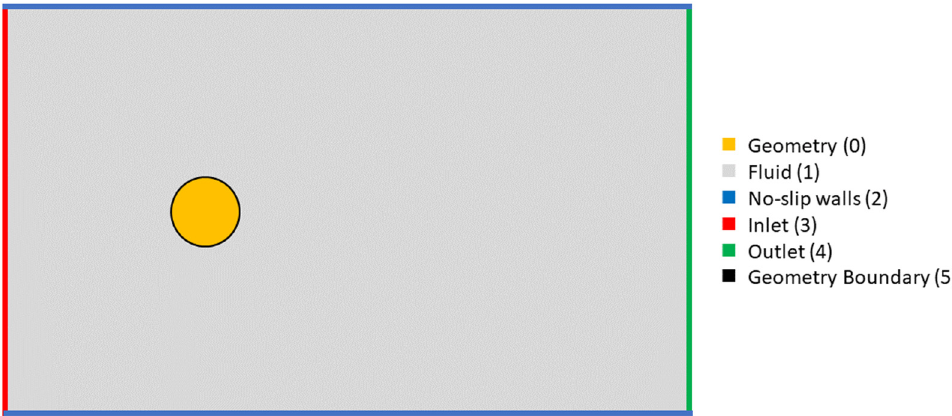
Figure 5. Diagram of the multi-class labelling of flow regions (not to scale).